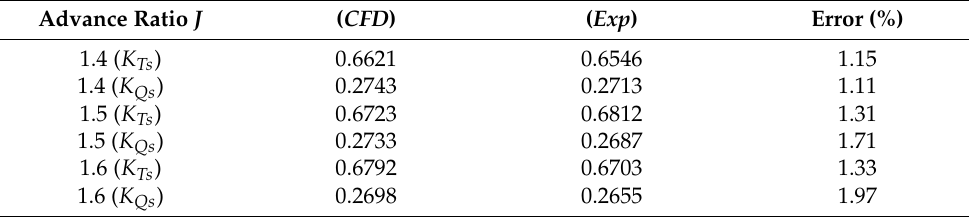
Table 6. The error of K Ts and K Qs